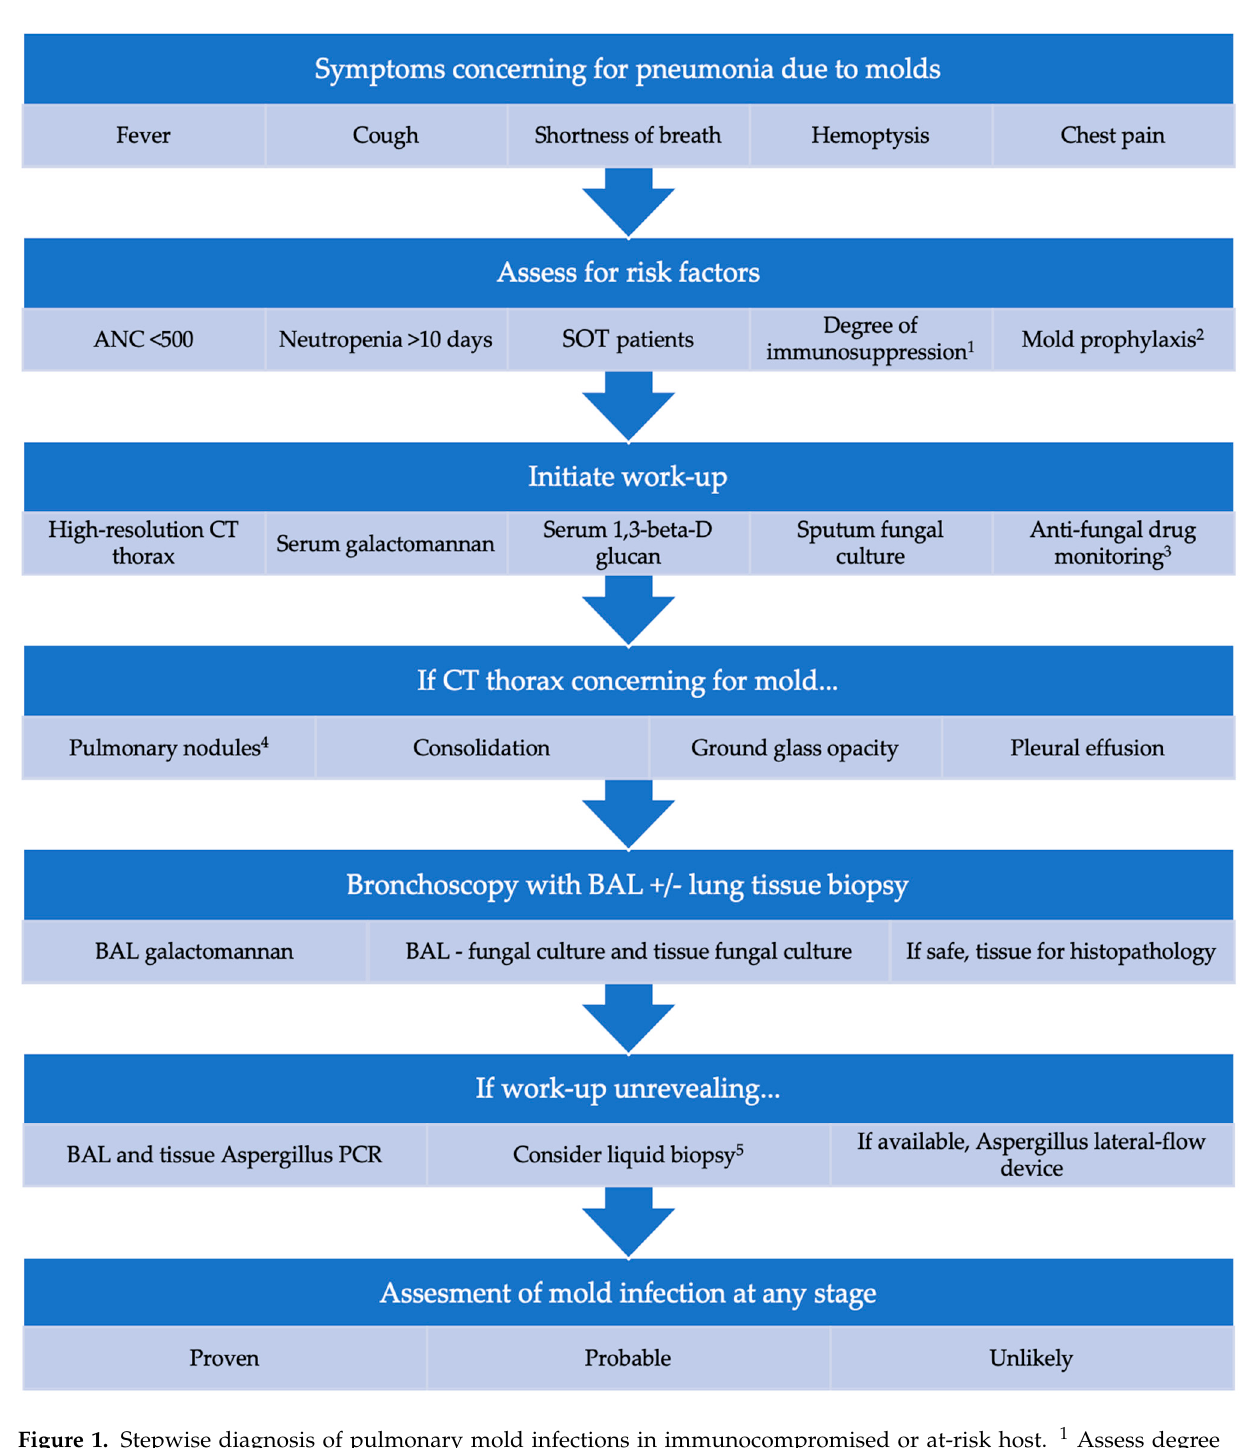
Figure 1. Stepwise diagnosis of pulmonary mold infections in immunocompromised or at-risk host. 1 Assess degree of immunosuppression including medications affecting T and B cells, tyrosine-kinase inhibitors, steroids, etc; 2 Patient would be at higher risk if not on anti-mold prophylaxis, such as voriconazole, posaconazole, or isavuconazole. Duration of anti-mold prophylaxis is also important; 3 Assess anti-fungal drug levels to ensure they are within therapeutic range (plasma drug level monitoring play an increasingly important role in optimizing the safety for voriconazole, and efficacy for posaconazole, and voriconazole of antifungals with significant interpatient pharmacokinetic variability); 4 Characteristic description of pulmonary nodules include halo sign, reverse halo sign, air crescent sign, hypodense sign; 5 Liquid biopsy or microbial cell-free DNA—sequencing of plasma used for species-level identification of organisms * If ongoing concern for disseminated mold infection, would evaluate for skin lesions on physical exam and rhinosinusitis with CT sinus. The development and revision of definitions for IFI will provide homogeneity for research, as well as provide an accurate resource for specialists in the field. Definitions